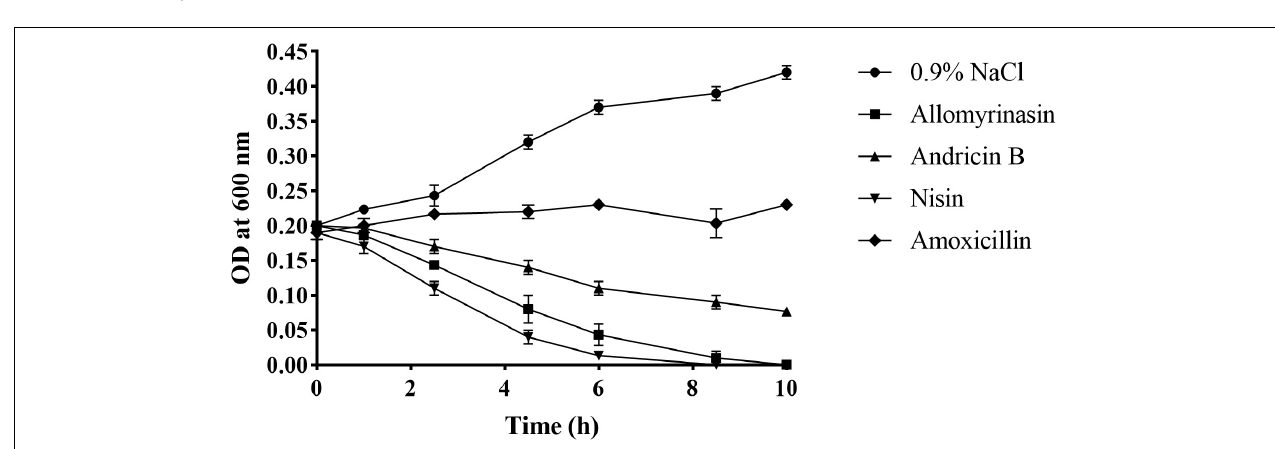
FIGURE 4 | Bacterial killing kinetics of Staphylococcus pseudintermedius MW767056 culture treated with 4 × minimal inhibitory concentration (MIC) allomyrinasin, andricin B, and amoxicillin by measuring absorbance at 600 nm over time. Nisin and saline served as positive and negative controls, respectively. All data represent the mean ± SD from the experiments performed in